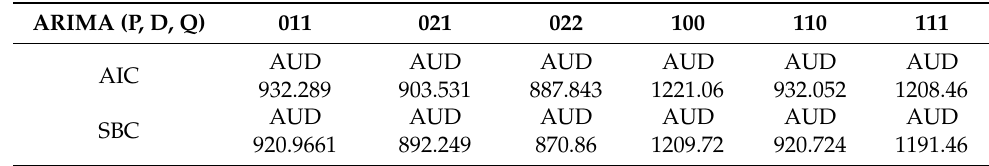
Table 5. ARIMA results with different P, D and Q